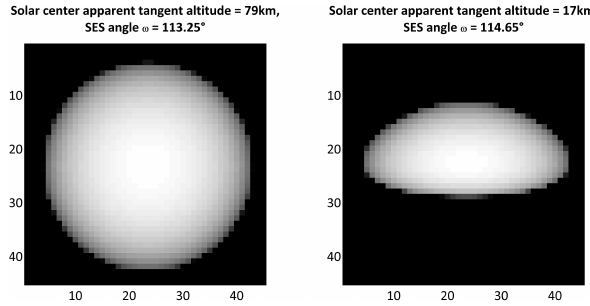
Fig. 2. Simulated pictures of the Sun. Left picture shows a high Sun, right picture shows a low Sun already experiencing strong flatten- ing. Notice the asymmetrical